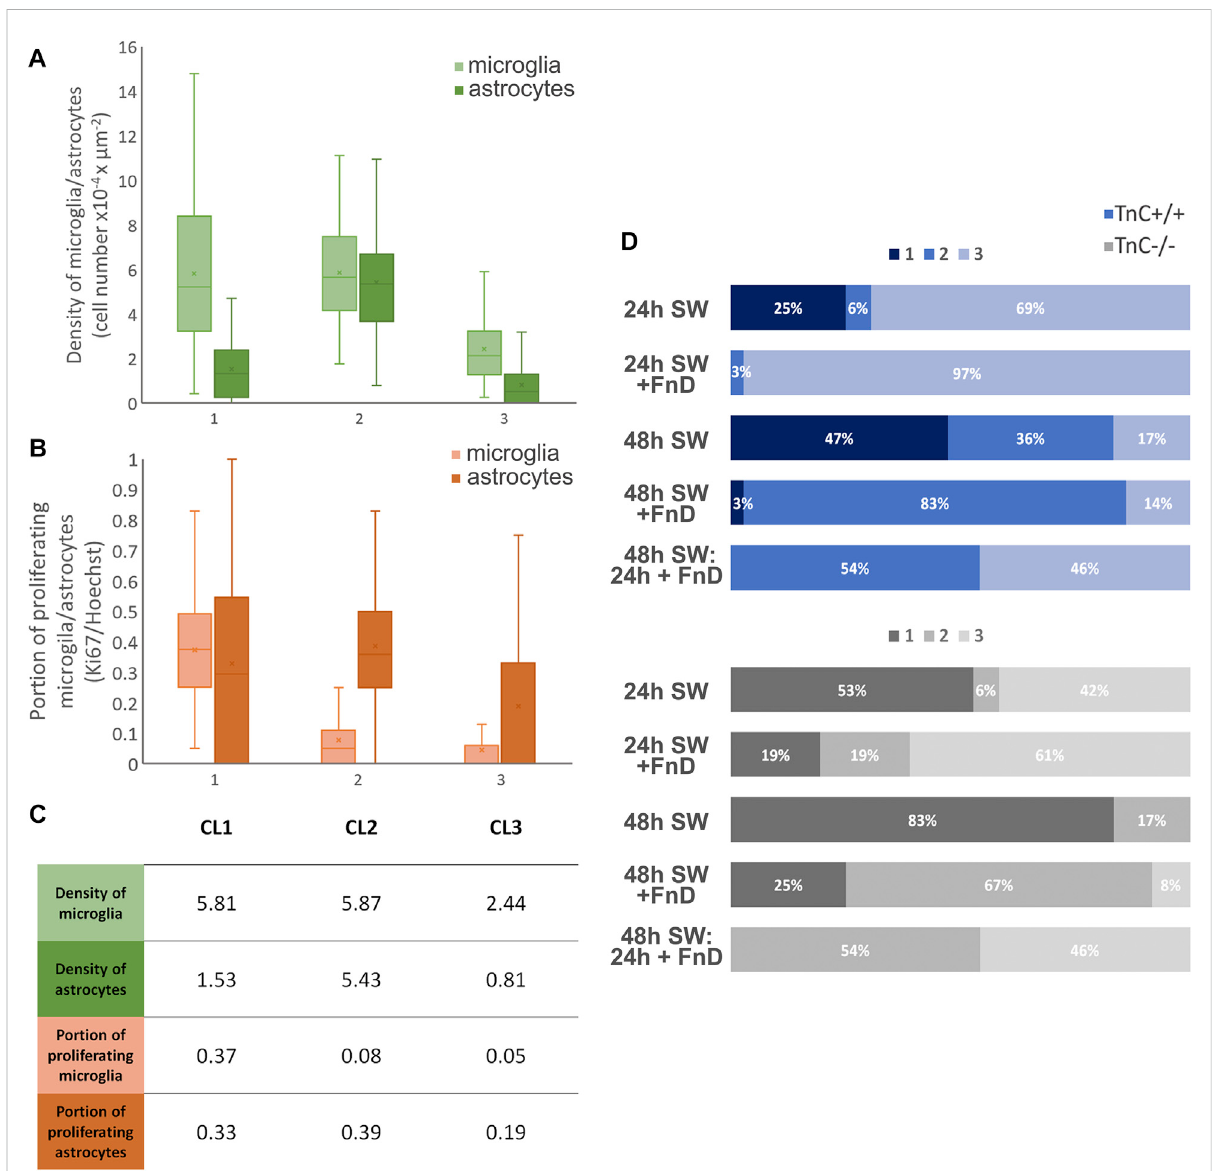
Responses of microglia and astrocytes in mixed cultures to SW ± FnD were distributed into three clusters based on cell density and proliferation. Range of values for densities of microglia and astrocytes per cluster are given as box — whisker plots (A) . Range of values for proliferation rates of microgliaandastrocytesperclusteraregivenasbox-whiskerplots (B) .Averagevaluesperparameterswhichrepresentclustercentresaregiven in table (C) . 100% stacked bar chart showing percentages of cluster membership per each group in respective genotype. HCA and K-means cluster analysis were used. Clusters were marked as 1, 2 and 3 (A,B,D) and CL1, CL2 and CL3 (C) (No. Images = 36, from three independent cultures, per treatment, per